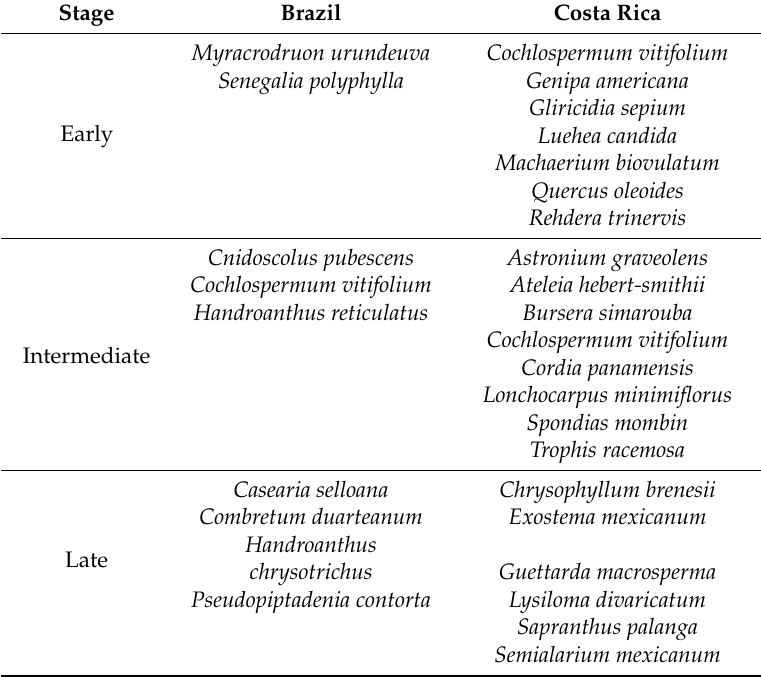
Table 1. List of the tree species selected for stemflow measurements per successional stage in both